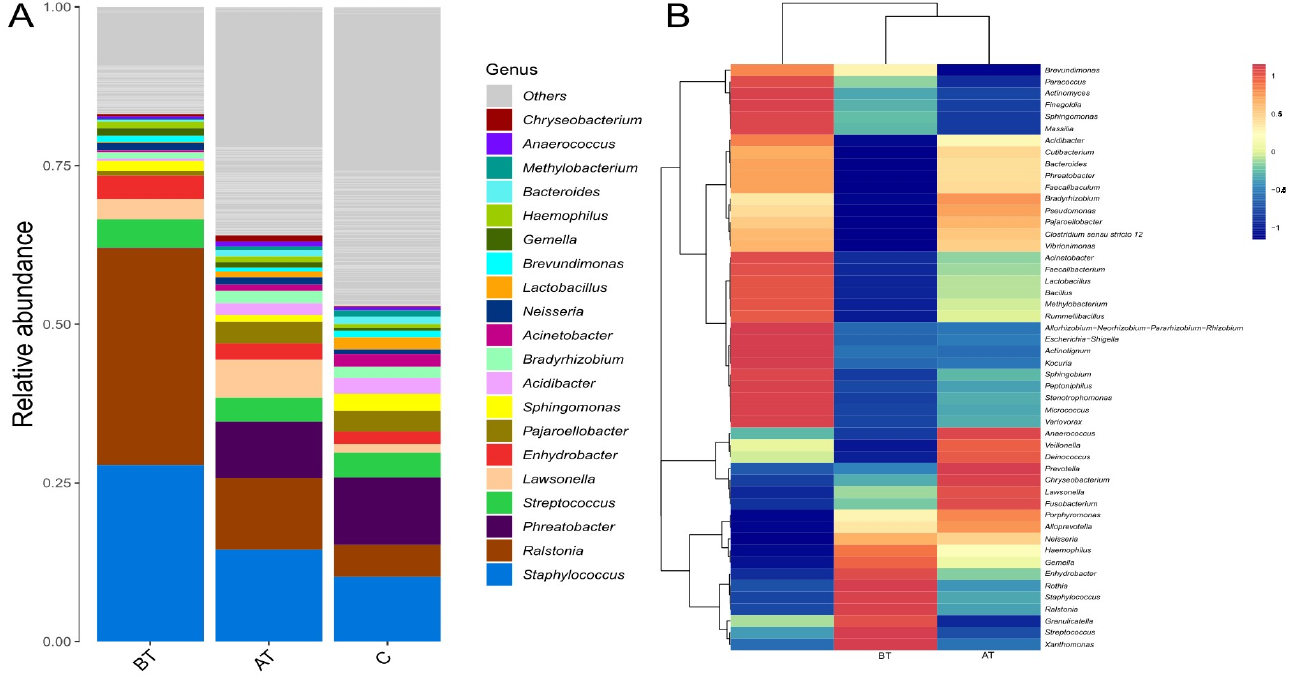
Figure 4. Relative abundance of facial microbiota at genus level among the pre-treated (BT), treated (AT), and control (C) groups. ( A ): Barplot presents relative abundance in percentage among the three experimental groups. ( B ): The correlation heatmap presents relative abundance in percentage among the three experimental groups at the genera level.